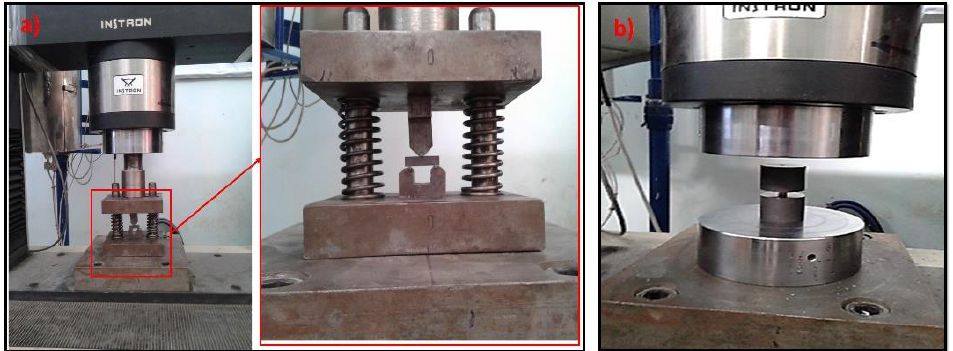
Figure 4. ( a ) The three-point bending setup, with an enlarged image of the measurement of the Transverse rupture strength (TRS) of the cemented carbide materials. ( b ) The compression-test